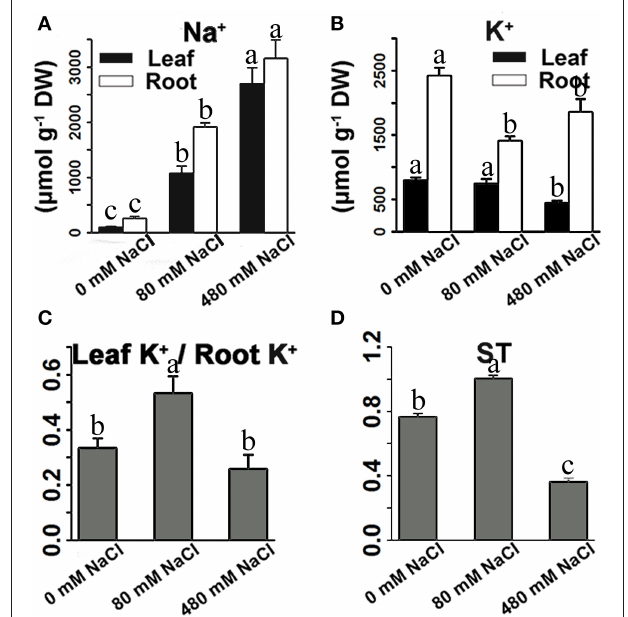
and ratio of leaf K + to root K + content (C) , and ST value (D) of K. sieversiana . The 30-d-old seedlings were subjected to 0, 80, and 480mM NaCl for 30 days. Selective transport capacity of ion (ST) is calculated using following formula: (root Na + /K + )/(leaf Na + /K + ). The greater ST value shows stronger capacity that root promotes K + to transport to leaf. The values are means of four replicates ( ± SE). Different letters above bars indicate significant differences among treatments, according to a least significant difference test ( P ≦